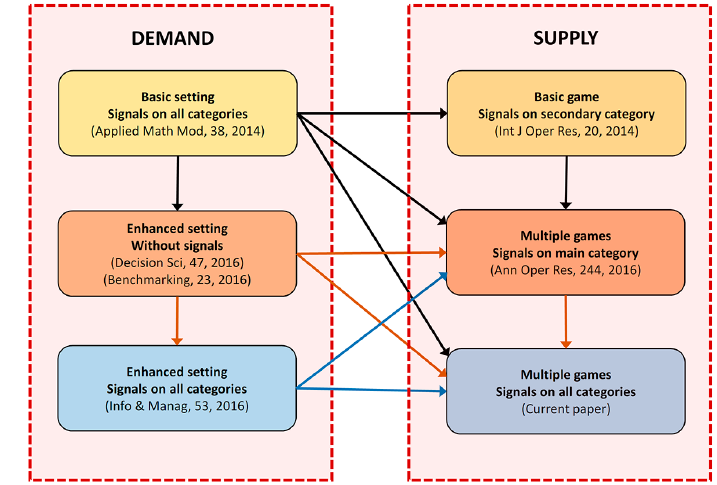
Figure 2. Building blocks of the current research